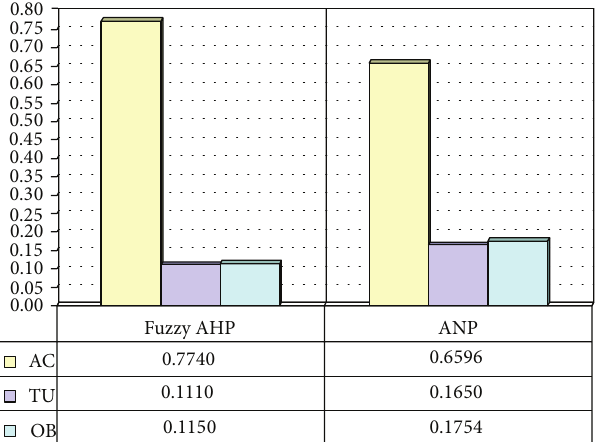
Figure 12: The results obtained from the FAHP and the ANP